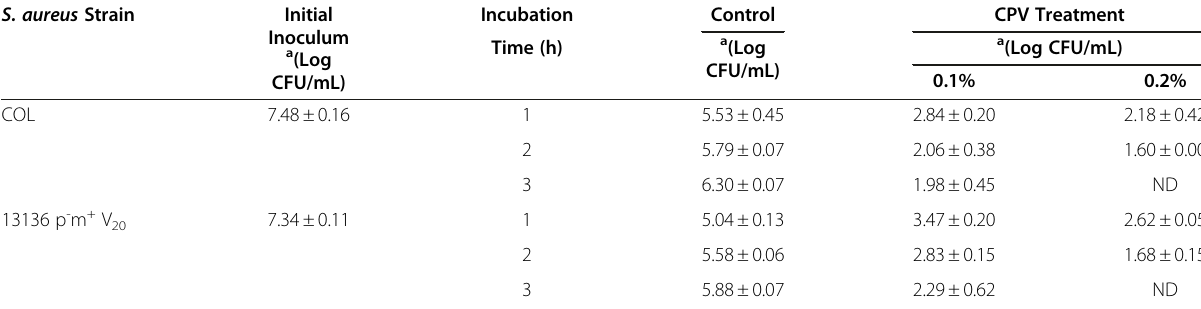
Table 2 Effect of CPV treatment on the total number of S. aureus infected with skin keratinocyte (HEK001) cell